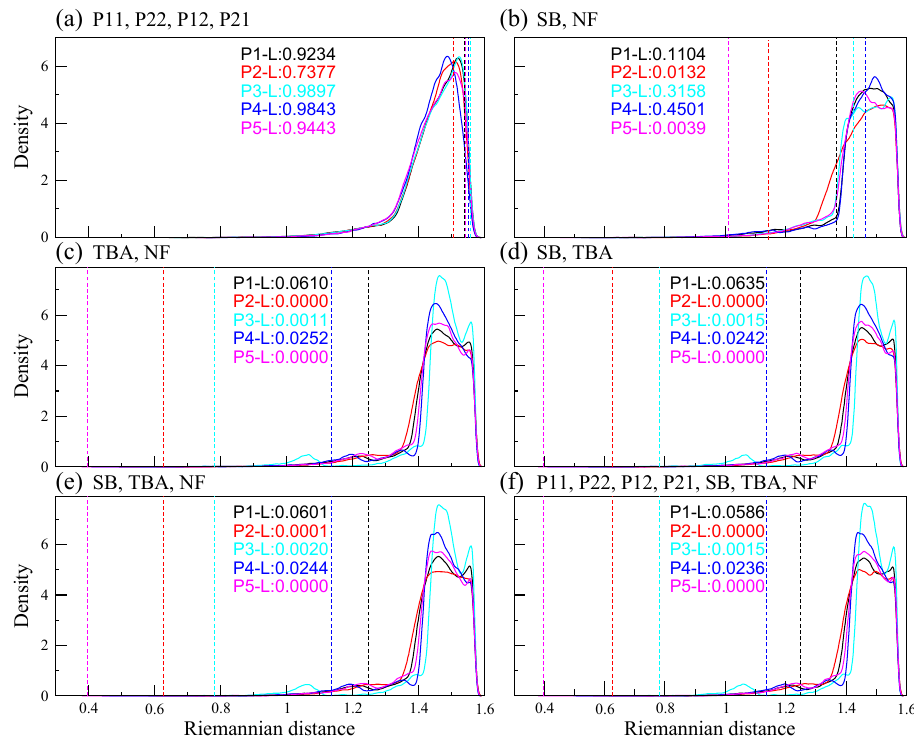
Figure 6. Behavior of the permutation test applying bootstrap simulation and Riemannian distances on different validation variables. ( a ) elements of the error matrix P11, P22, P12 and P21. ( b ) sum of biomass and number of fires. ( c ) number of fires and total BA. ( d ) sum of biomass and total BA. ( e ) sum of biomass, total BA, and number of fires. ( f ) all the elements of the error matrix: P11, P22, P12 and P21, sum of biomass, total BA, and number of fires. Here P1, P2, P3, P4, P5 and L stand for MCD64C5.1, MCD64C6, MCD45, Fire CCI 4.1, Fire CCI 5.0 and reference data.